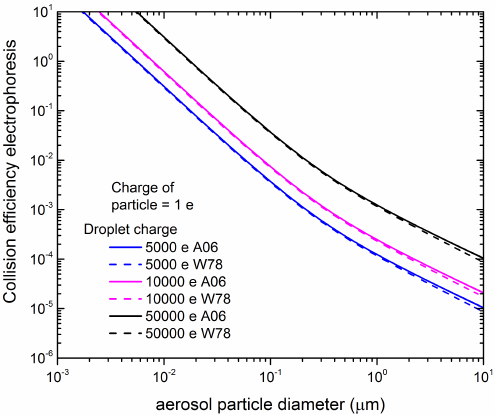
Figure 7. Dependence of electrophoresis on droplet charges for the formulations of Andronache et al. (2006) (A06) and Wang et al. (1978) (W78). The legend indicates the elementary charge on the droplets. The aerosol particles carry one elementary charge.